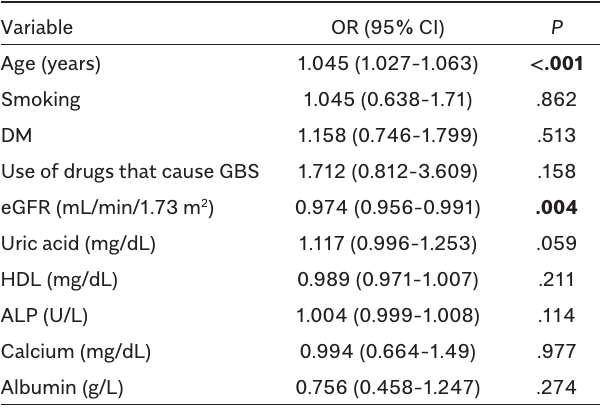
Albumin (g/L) .274 The variables with P < .2 in the univariate analysis were included in the multi- variable model. Statistically significant findings are indicated in bold. eGFR, estimated glomerular filtration rate; DM, diabetes mellitus; GBS, gallbladder stone; HDL, high-density lipoprotein; ALP, alkaline